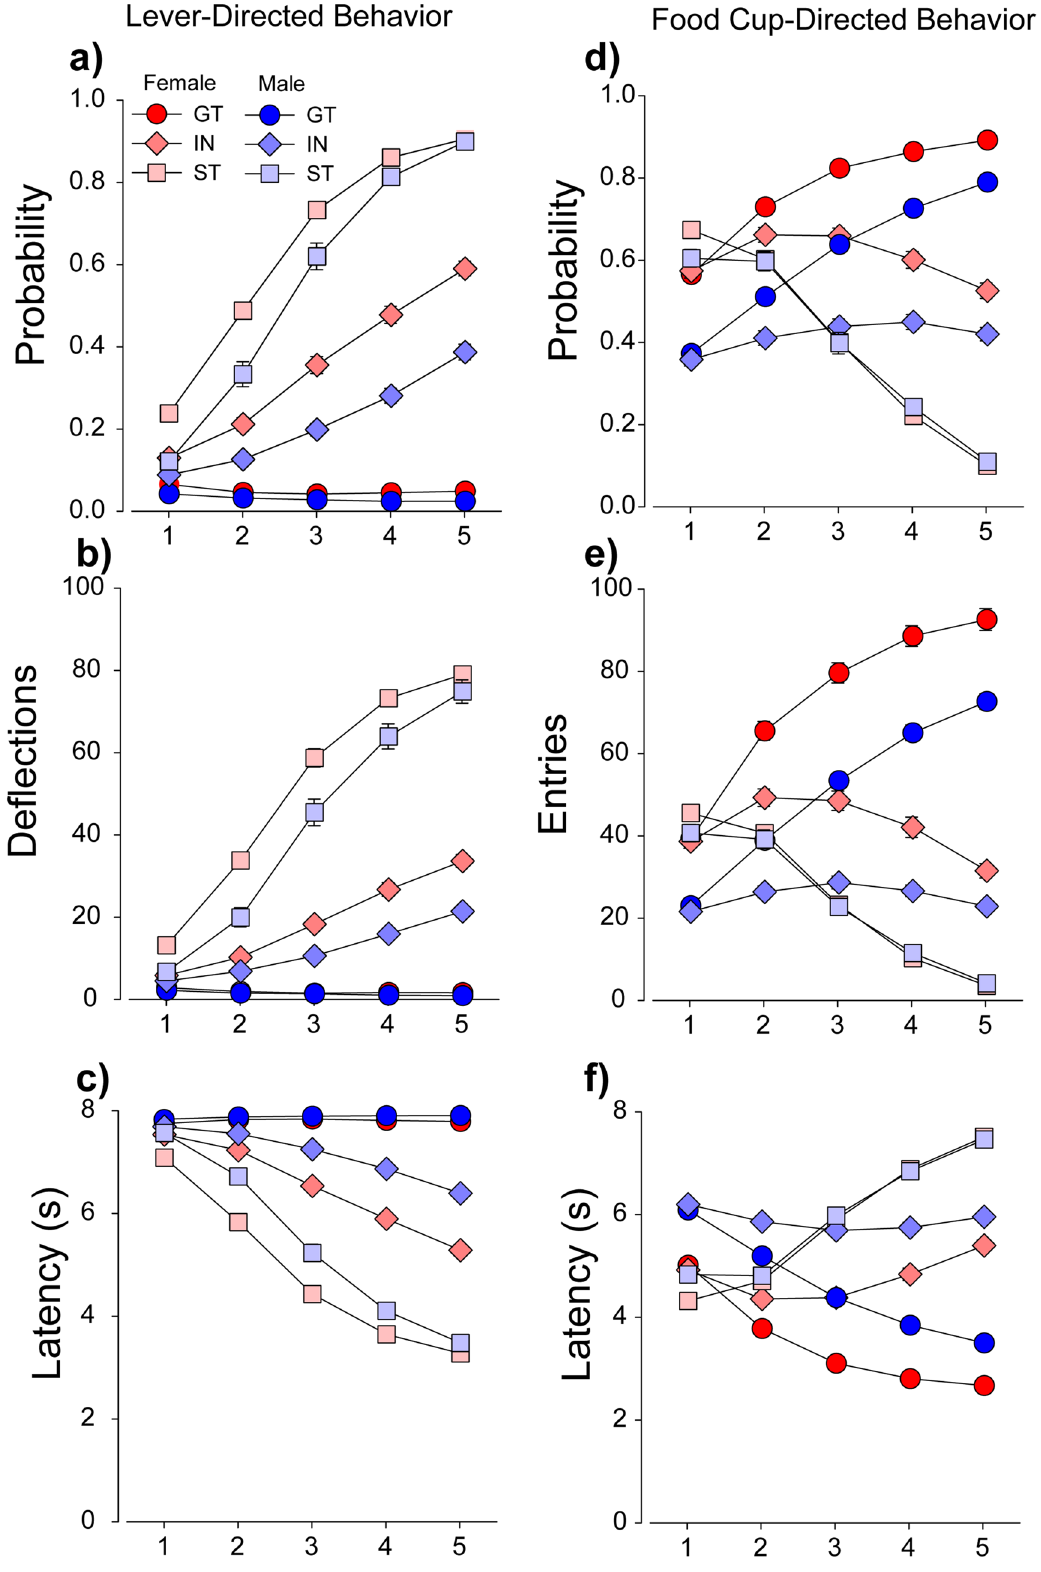
Figure 2. Individual measures of tendency to sign- and goal-track used to calculate PavCA index (UBuff). Performance of intermediates (IN), sign- (ST) and goal-trackers (GT) across 6 major behavioral measures during Pavlovian conditioned approach. Sign trackers showed ( a ) a higher probability of deflecting the lever, ( b ) increased number of lever deflections, and ( c ) faster latency to deflect the lever than intermediates and goal-trackers. Further, this effect was larger in females across all three PavCA phenotypes. Conversely, goal-trackers showed ( d ) higher probability of entering the food cup, ( e ) more food cup entries, and ( f ) quicker latency to enter the food cup than intermediates and sign-trackers. Similarly, this effect was more robust in females across all three